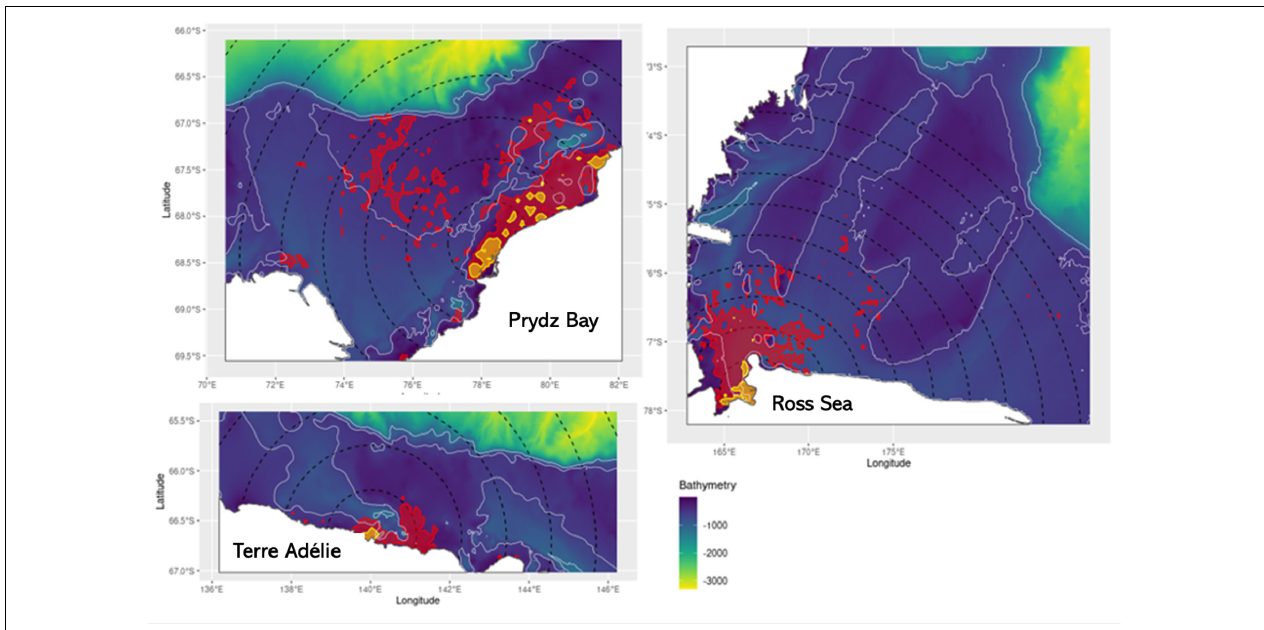
FIGURE 3 | The sample Utilisation Distributions for Weddell seals at each location. These represent the number seal days per 5 × 5 km pixel and were calculated as the product of the mean of the individual UDs (mean days per pixel) and the total number of seals that used each pixel. The yellow areas enclose the cells in which 50% of all seal days occurred (which we regard as the core UD for each population) and the red polygons enclose the cells in which 90% of all seal days occurred. The black dotted lines indicate 50 km bands from the centre of the overall distribution (defined as the most commonly used 5 × 5 km pixel). The white contours represent the –1000 and –500 m bathymetric